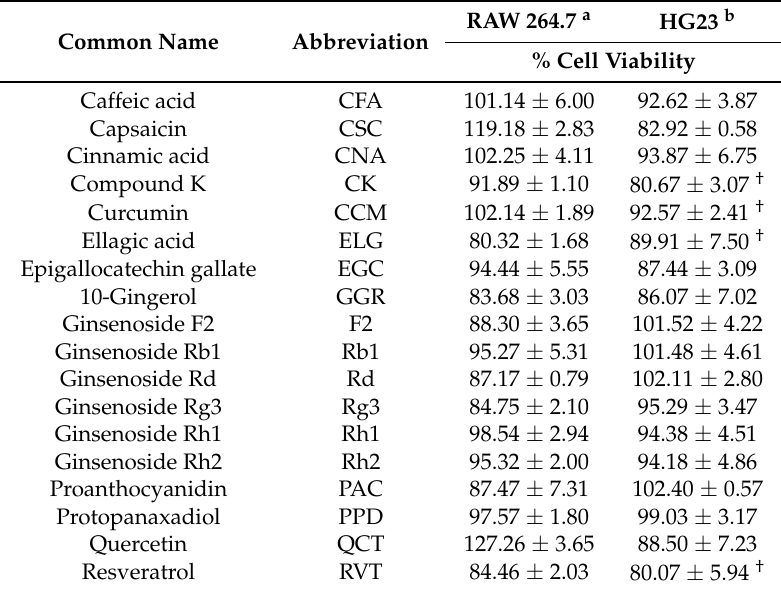
Table 1. Evaluation of cytotoxicity of phytochemicals in two different cell